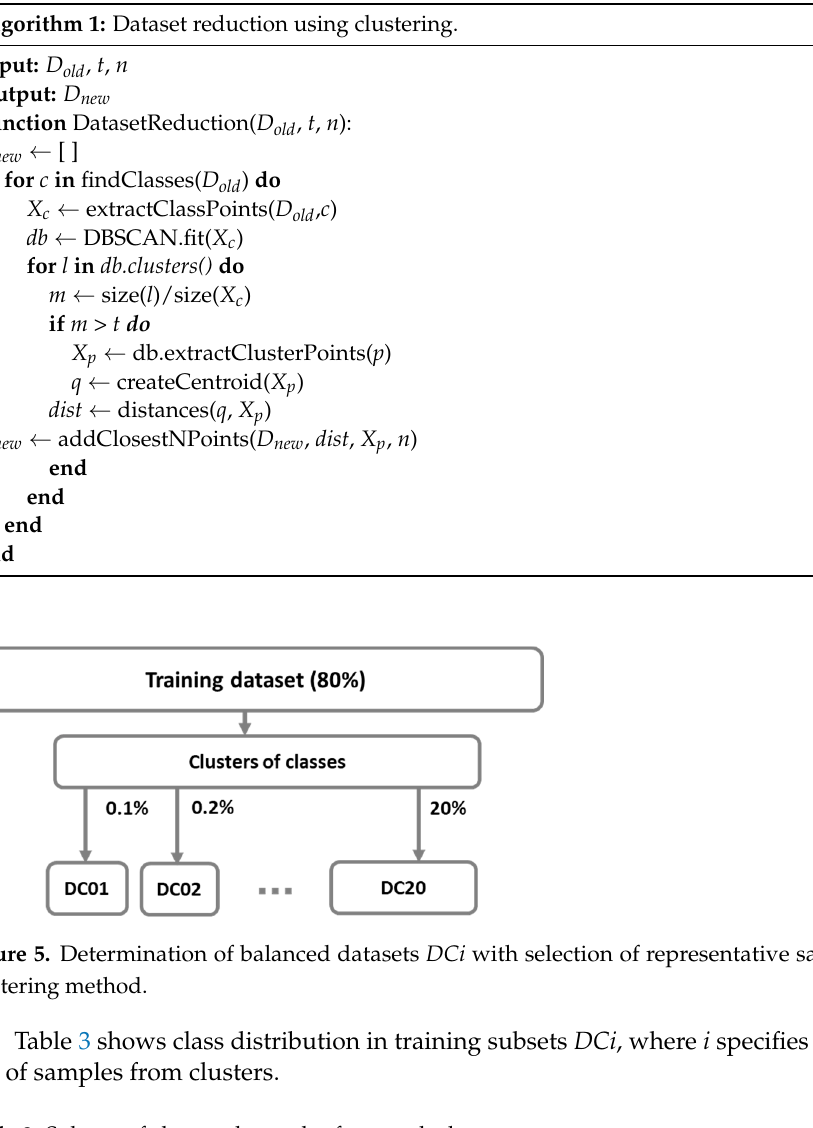
Table 3. Subsets of clustered samples from each class.